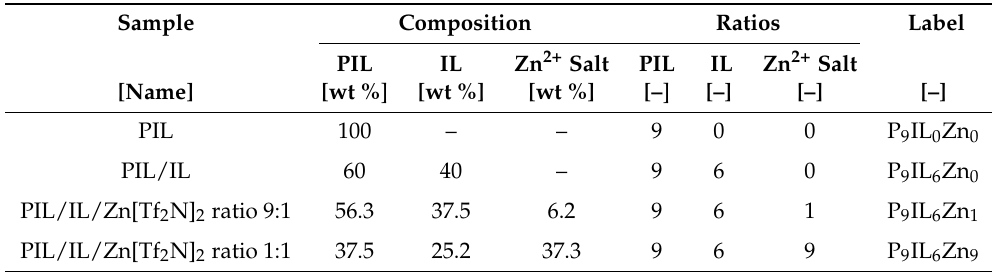
Table 1. Composite PIL/IL/Zn 2+